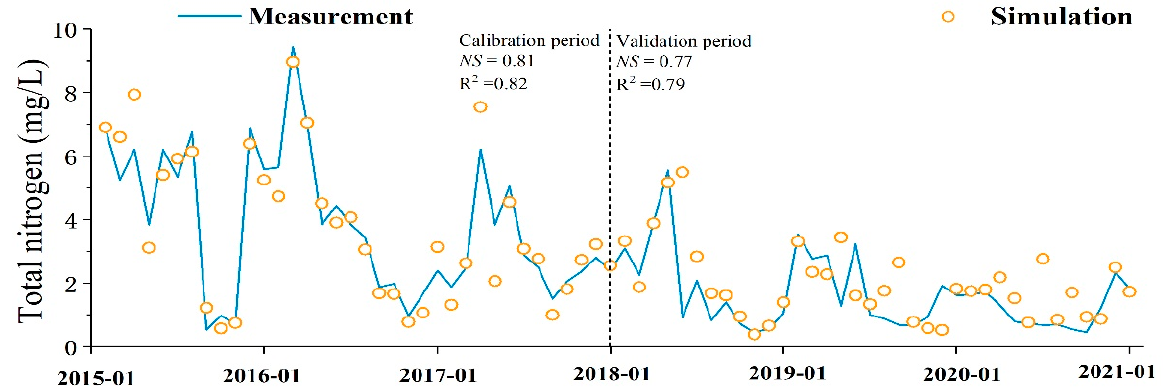
Figure 7. Comparison of runoff rate determination and validation.